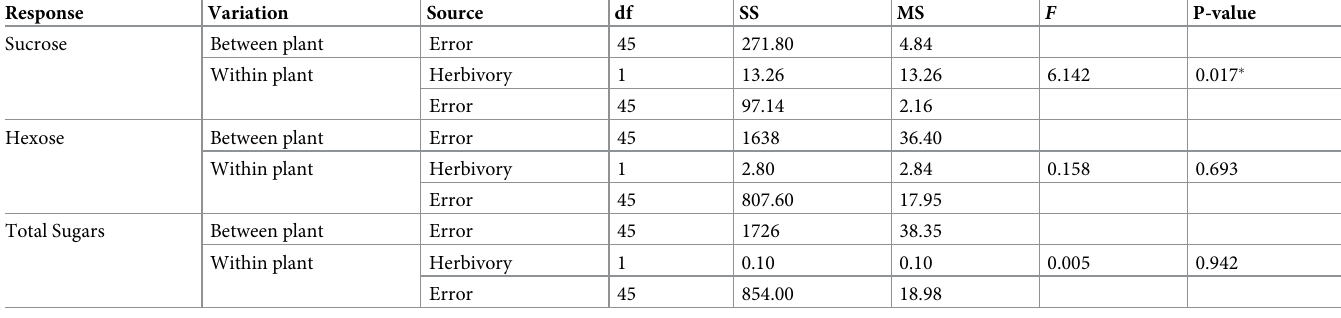
Table 1. Analysis of variance table: Repeated measures ANOVA test for effects of herbivory. Sucrose, hexose, and total sugar content of G . hirsutum EF nectar was compared before and after herbivore exposure. Response Variation